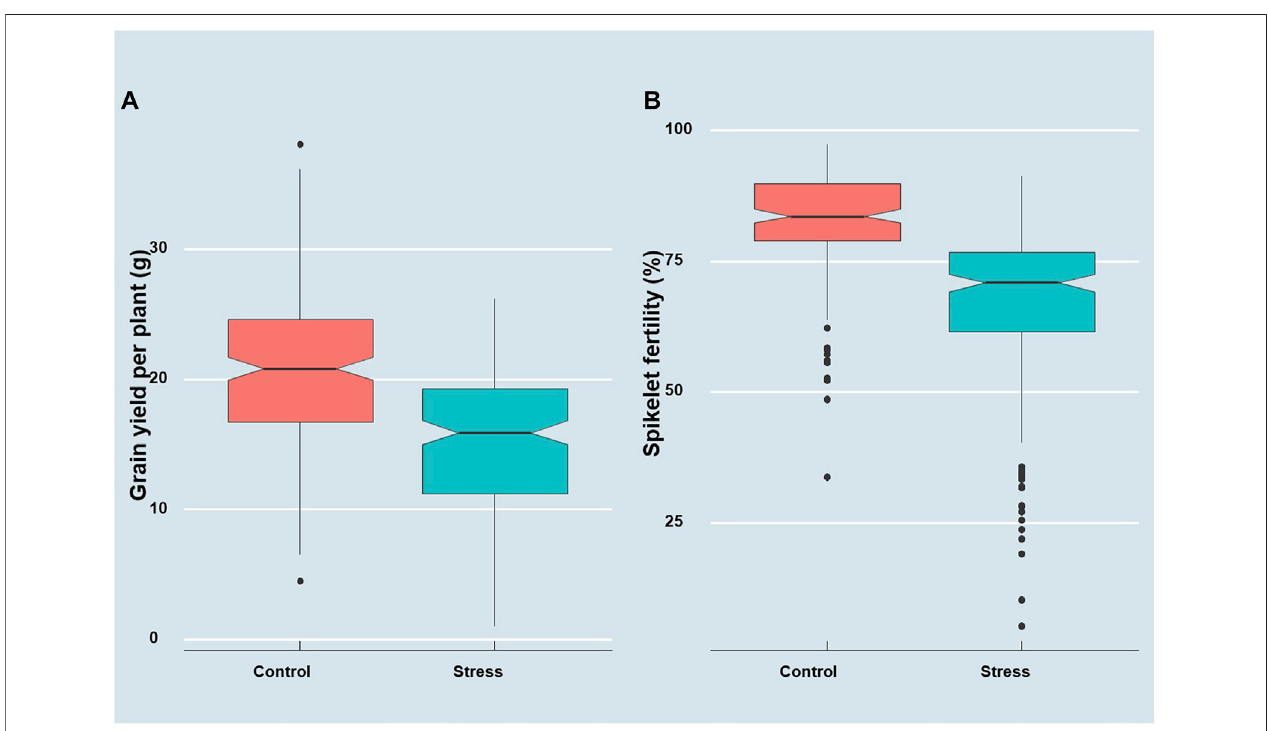
FIGURE 1 | Boxplots depicting the distribution of (A) grain yield plant − 1 (g) and (B) spikelet fertility (%) under control and heat stress